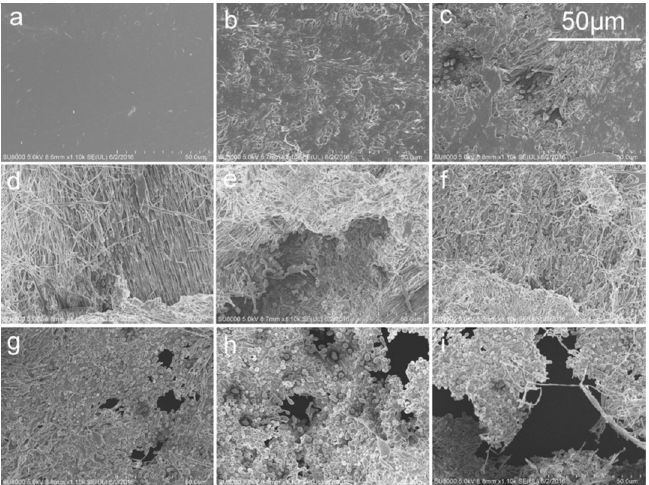
Figure 10. SEM surface structure of PBS/PLA/benzoyl peroxide (BPO) films degraded by proteinase Figure 8. SEM surface structure of PBS / PLA / benzoyl peroxide (BPO) films degraded by proteinase K. ( a K. ( a ) 0 h; ( b ) 12 h; ( c ) 24 h; ( d ) 36 h; ( e ) 48 h; ( f ) 60 h; ( g ) 72 h; ( h ) 84 h; ( i ) 96 h [43].